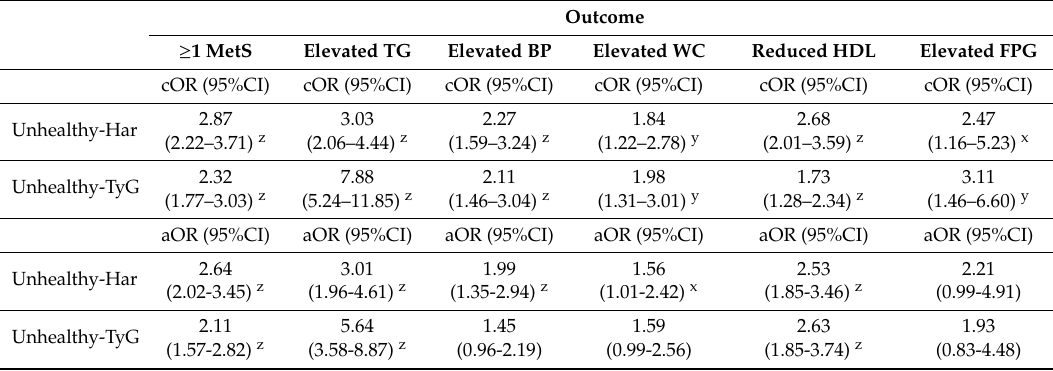
Table 3. Odd ratios of outcomes according to the Harmonized Criteria and TyG-i (with healthy individuals as the reference in each